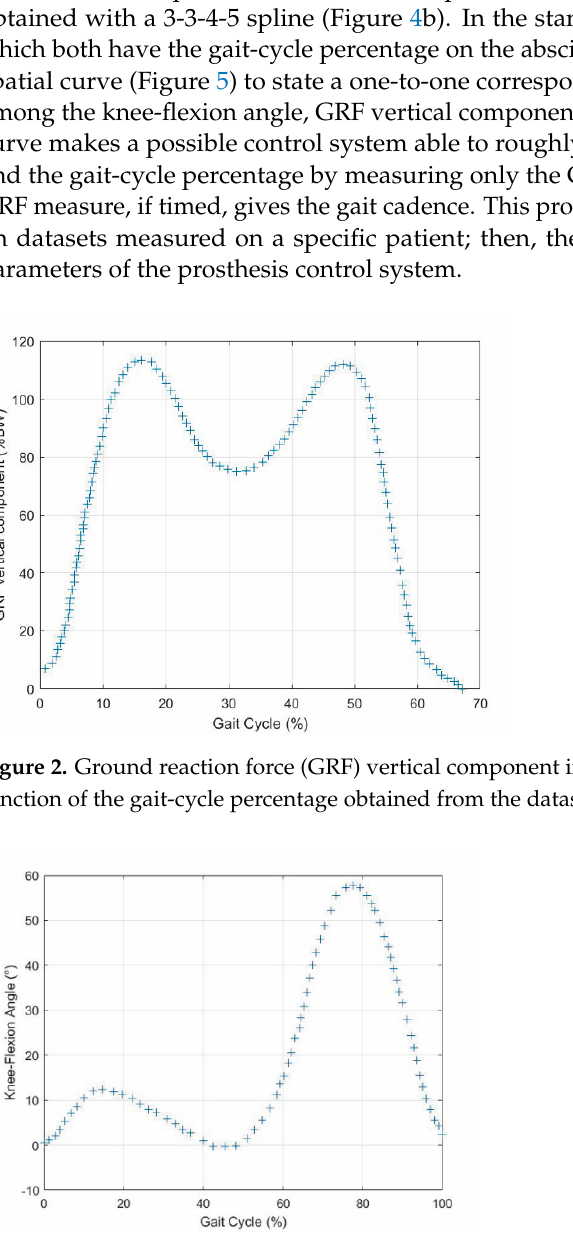
Figure 3 . Diagram of the knee-flexion angle as a function of the gait-cycle percentage obtained from the dataset reported in [34].